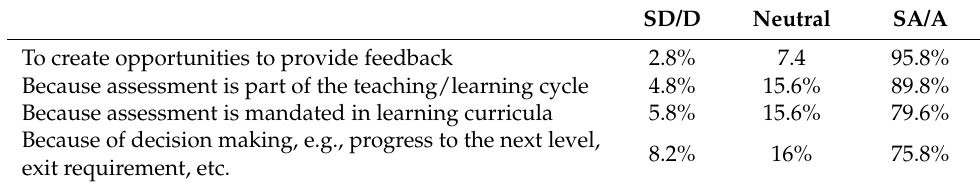
Table 4. Teachers’ perceptions of assessment purposes during the